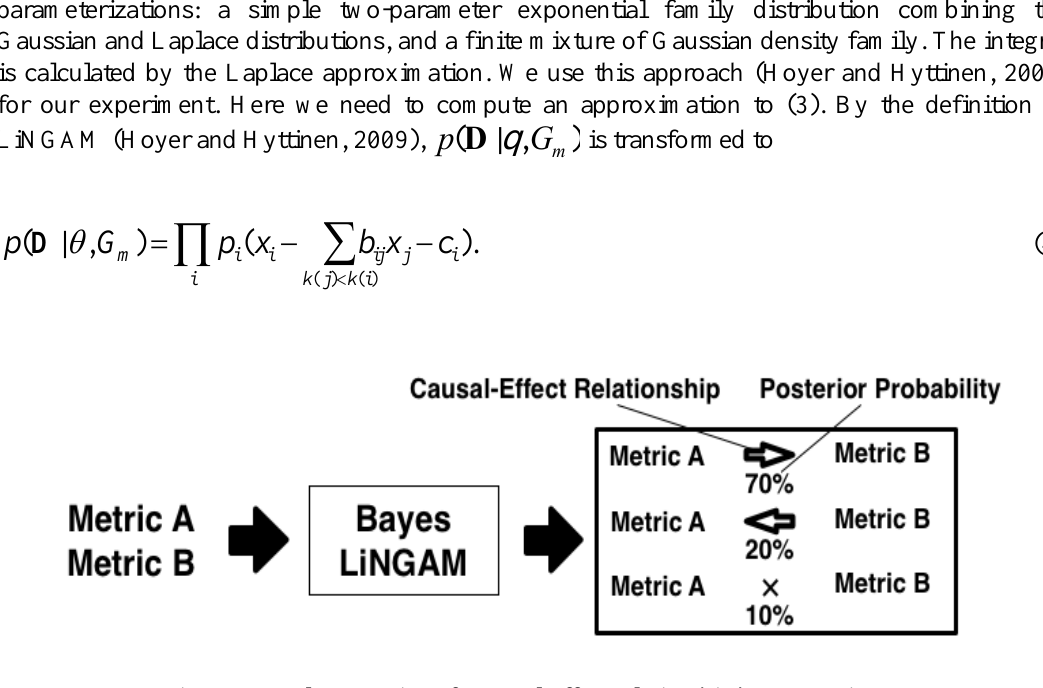
Fig. 2. Example extraction of a causal-effect relationship by BayesLiNGAM